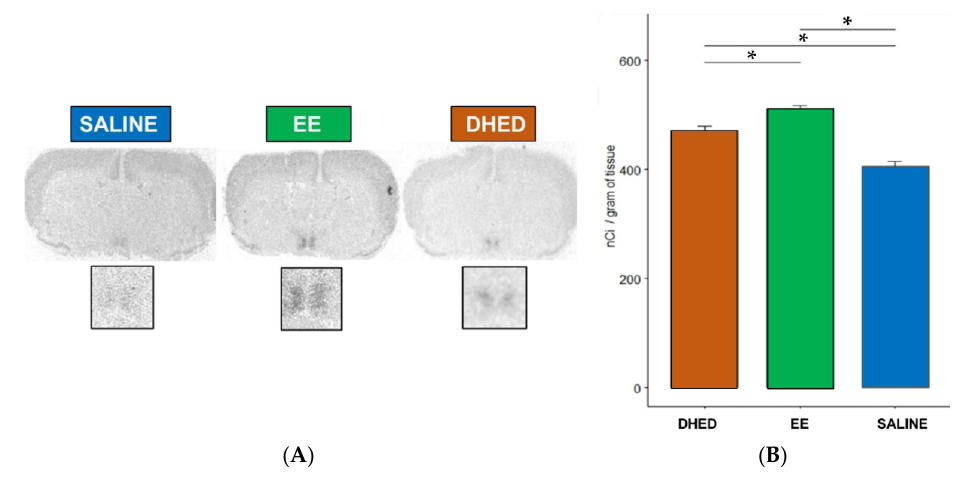
Figure 4. Like the synthetic estrogen EE, DHED stimulated the expression of PR in the preoptic area (POA) after p.o. administration. The optical densities of film exposures over the POA in panel ( A ) of the figure are shown in the chart ( B ). Statistical significance: * p < 0.05 by ANOVA followed by post hoc Tukey test.